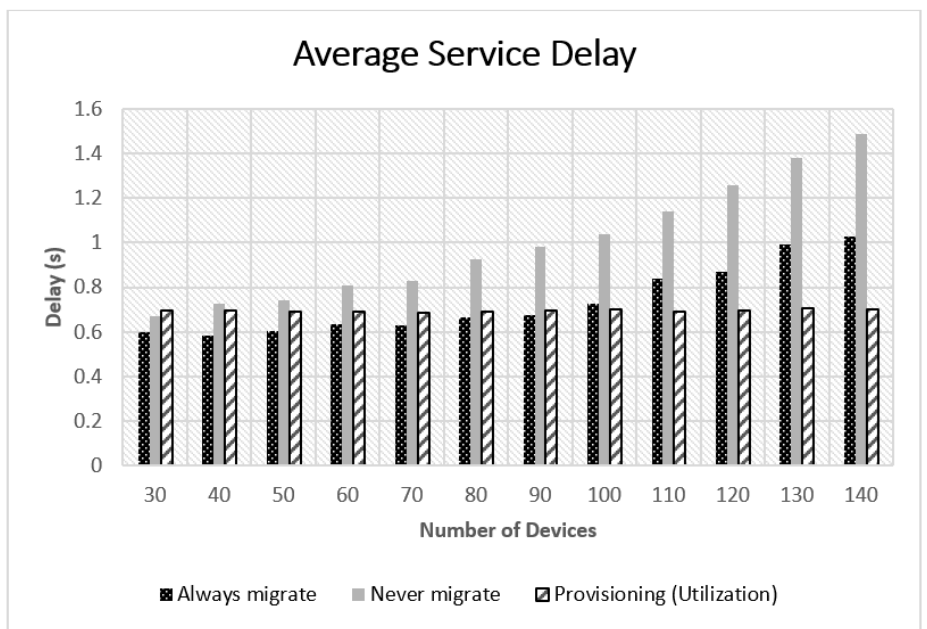
Figure 3. Always, never, and provisioning-based migrations comparison.